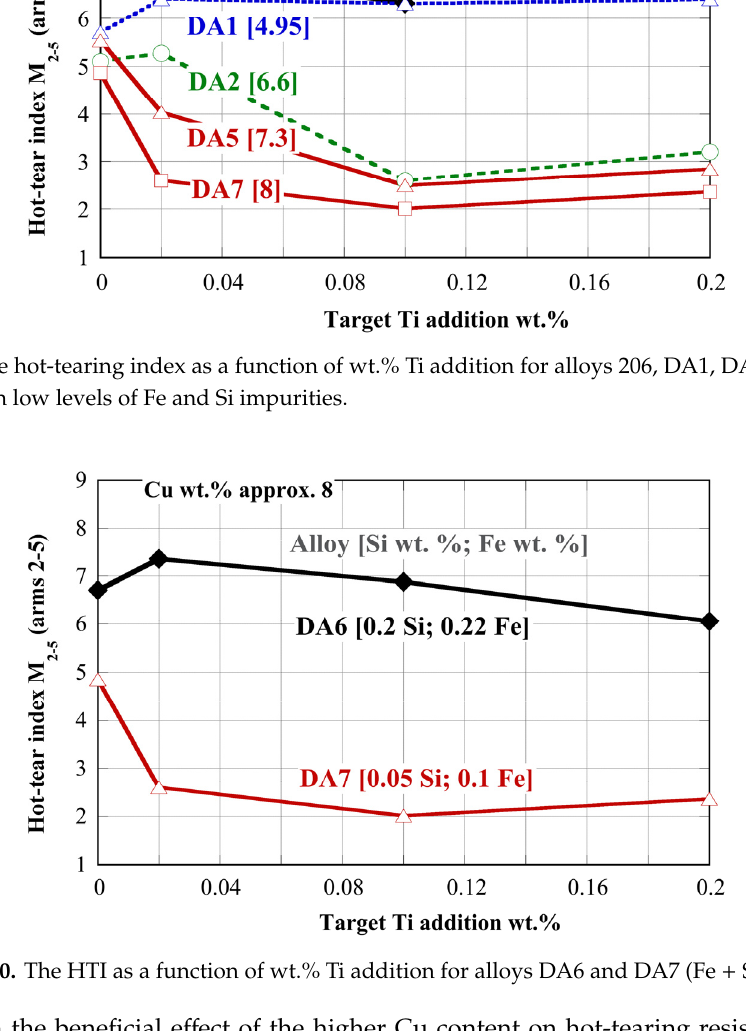
Table 5. Hot-tearing indices M S and M 2–5 from multi-arm castings.